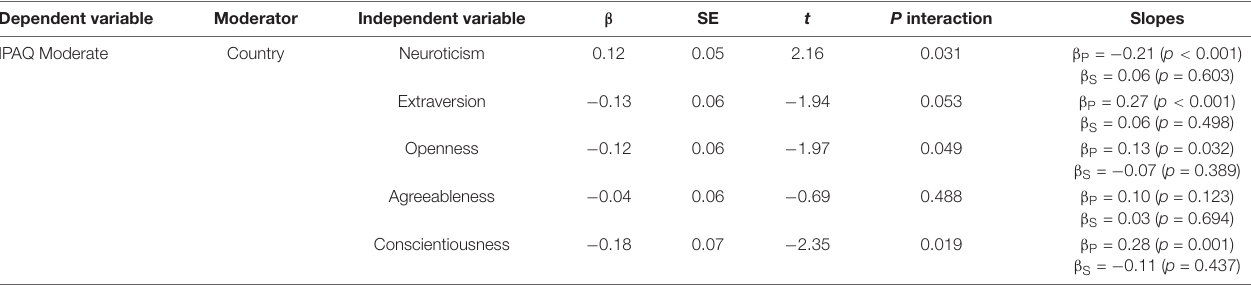
TABLE 4 | Moderation analysis–moderating variable: country; dependent variable: IPAQ moderate. Dependent